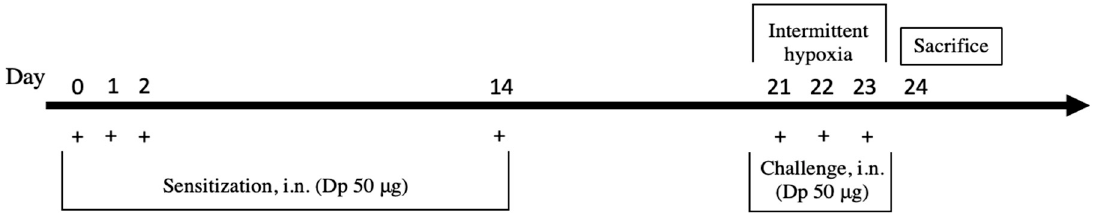
Figure 5. Diagram of intermittent hypoxia exposure. The mice in the control group received intranasal administration with normal saline seven times. They lived in normoxia conditions throughout the experiment. For the induction of allergic asthma, mice in the Dp group were sensitized intranasally using 50 µ g Dp extract, resuspended in PBS. Mice in the Dp+IH group received Dp administration and were, at the same time, exposed to IH for three days. Mice in the CTL+IH group were exposed to IH without Dp